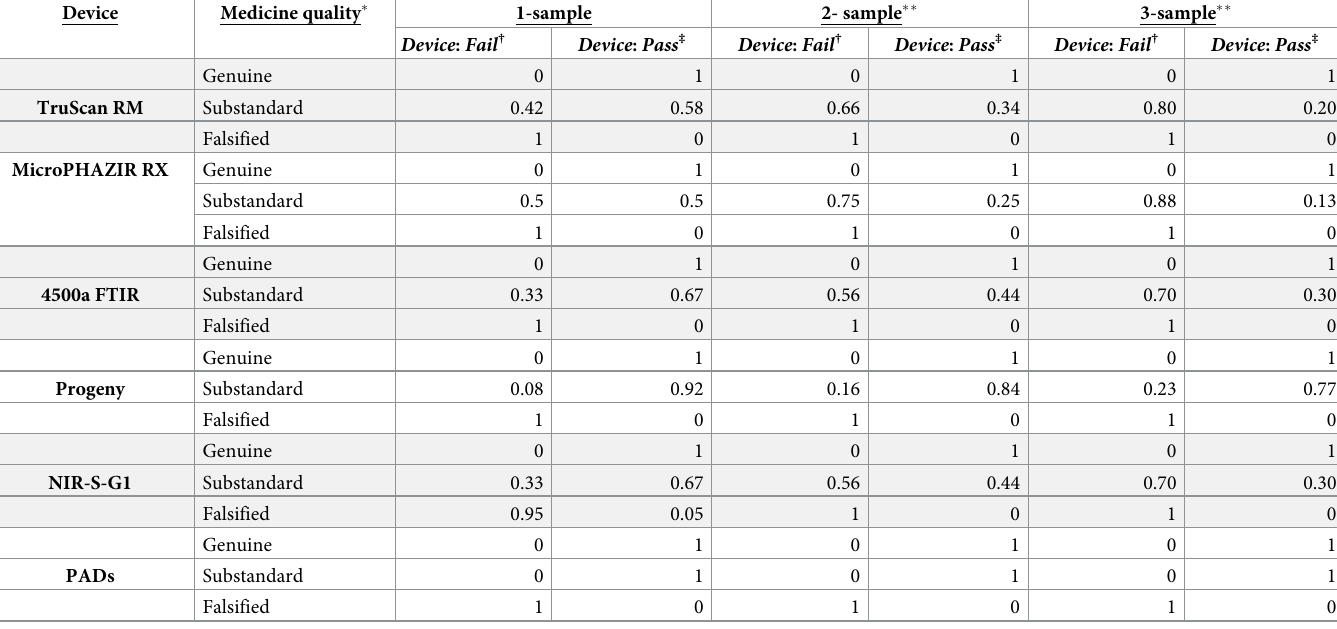
Table 1. Probability with which each device will identify genuine, substandard (between 50% and 80% API) and falsified (wrong/0% API) medicines with strategies of 1/2/3 samples per brand of ACTs.